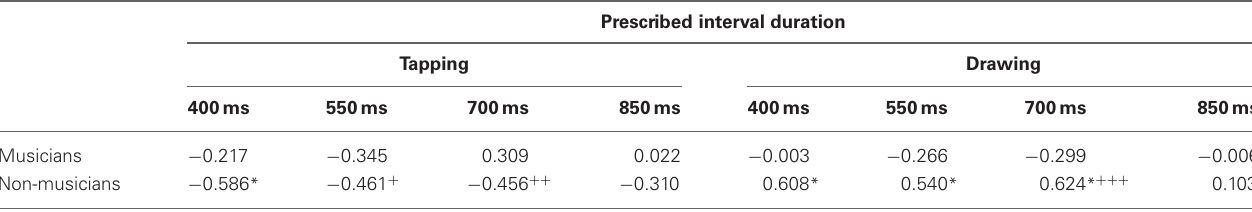
Table 2 | Correlations between normalized mean squared jerk ( Z -coordinate for tapping; X coordinate for drawing) and detrended IRI variance. Prescribed interval